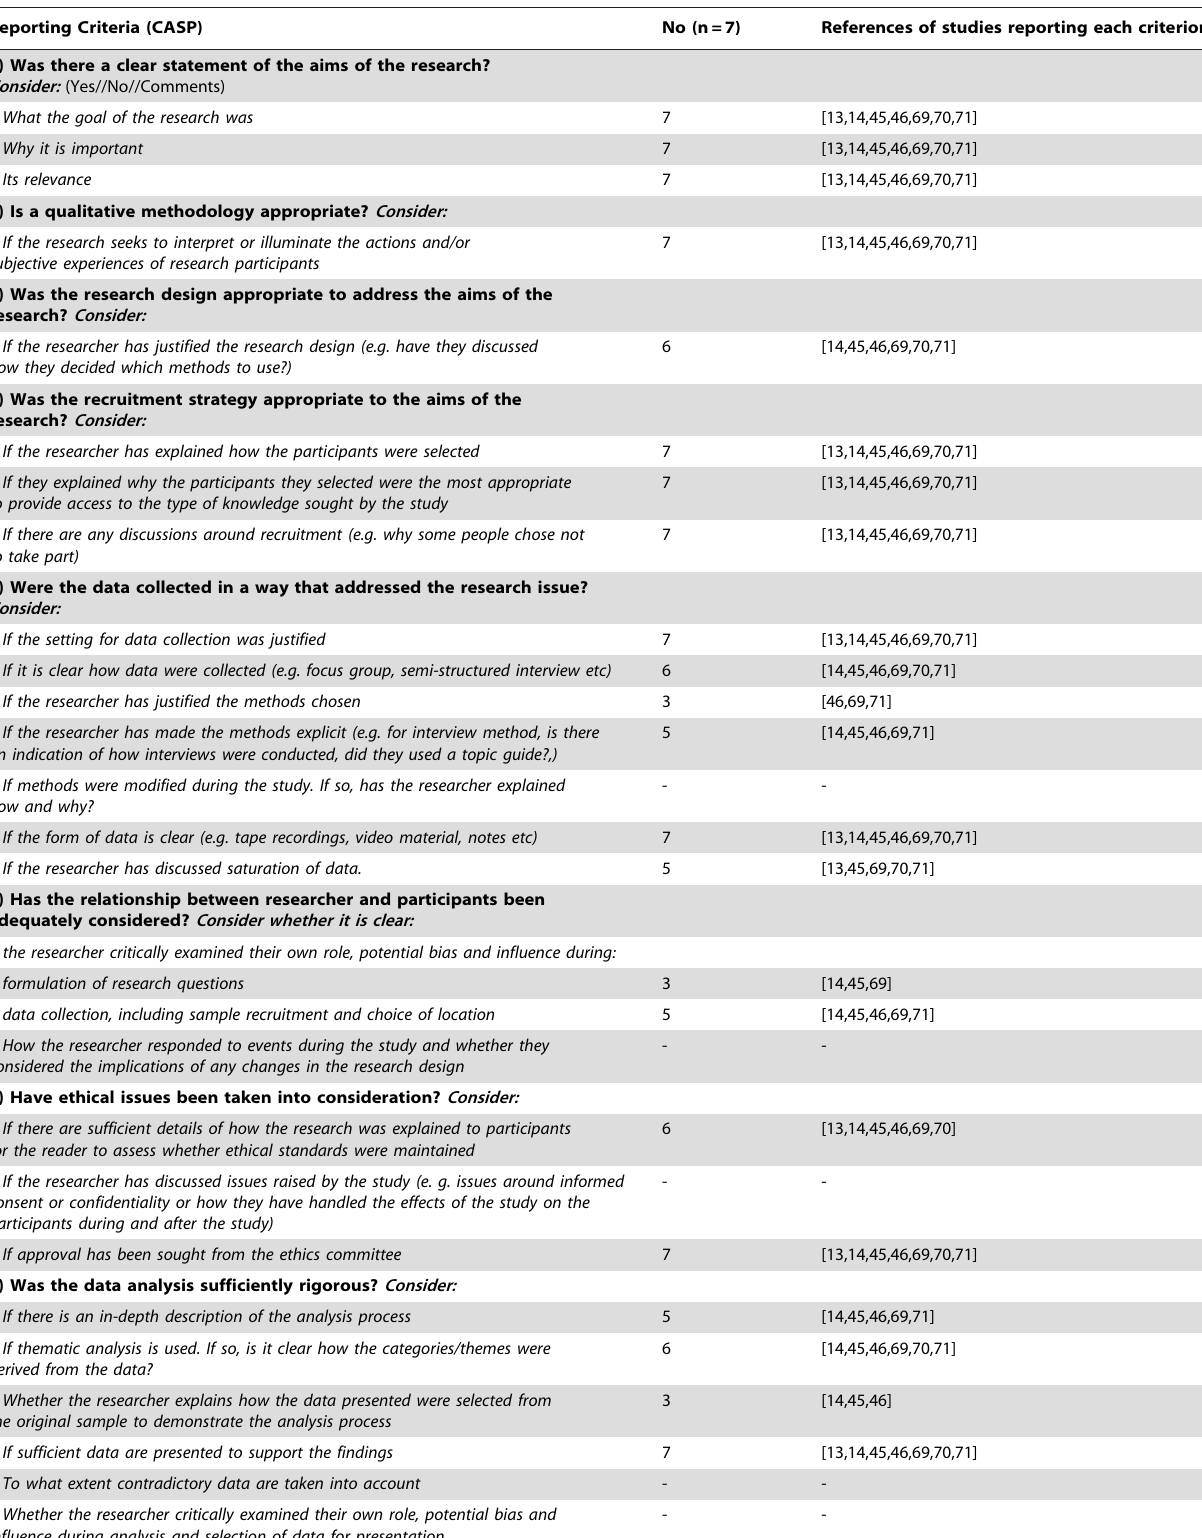
Table 2. Methodological Quality of included studies assessed with CASP (1999): qualitative research